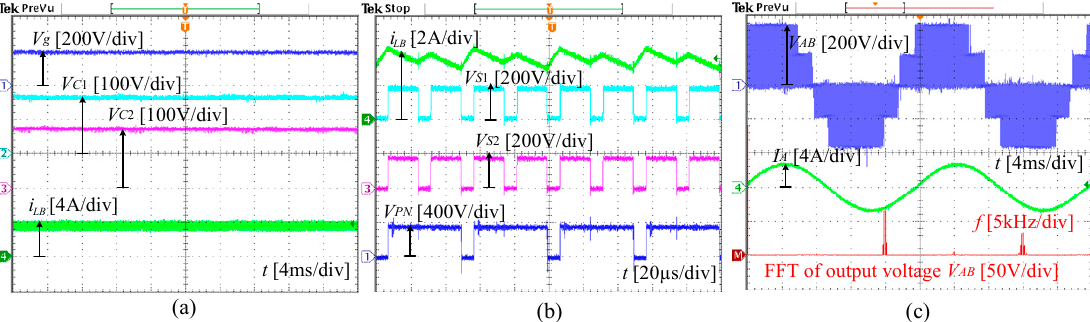
Figure 12. Experimental results of the inverter under the proposed method when V g = 200 V. From the top to bottom: ( a ) V g , V C 1 , V C 2 , and i LB ; ( b ) i LB , V S 1 , V S 2 , and V PN ; ( c ) V AB , I A , and FFT spectrum of the output voltage V AB .